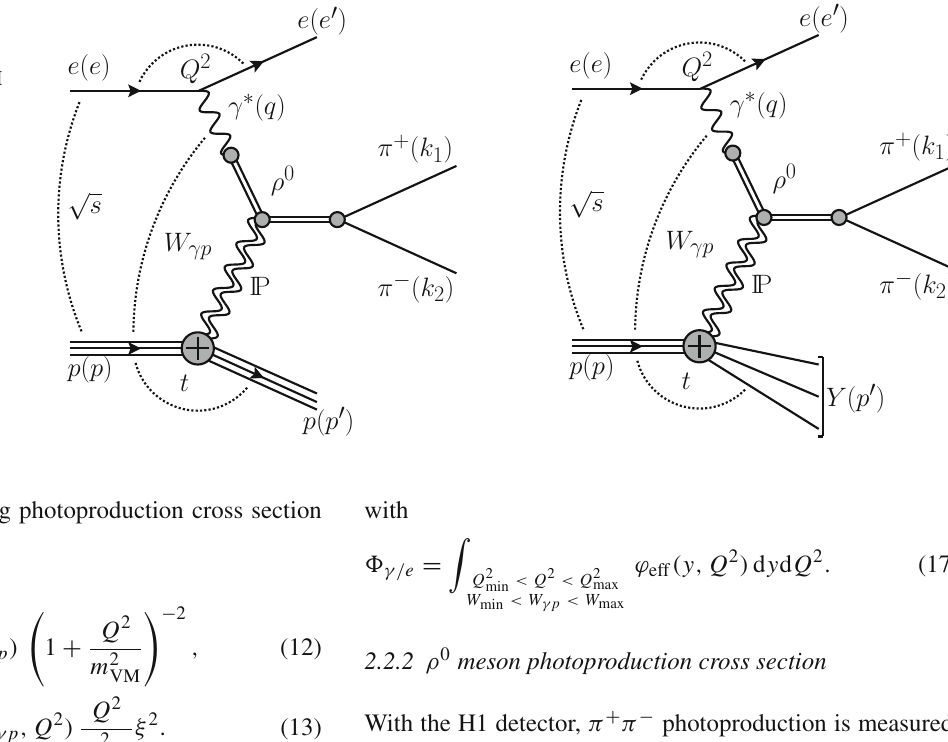
Fig. 2 Diagram of ρ 0 meson production and decay in elastic (left) and proton-dissociative (right) ep scattering in the VDM and Regge picture, where the interaction is governed by soft pomeron exchange in the high energy